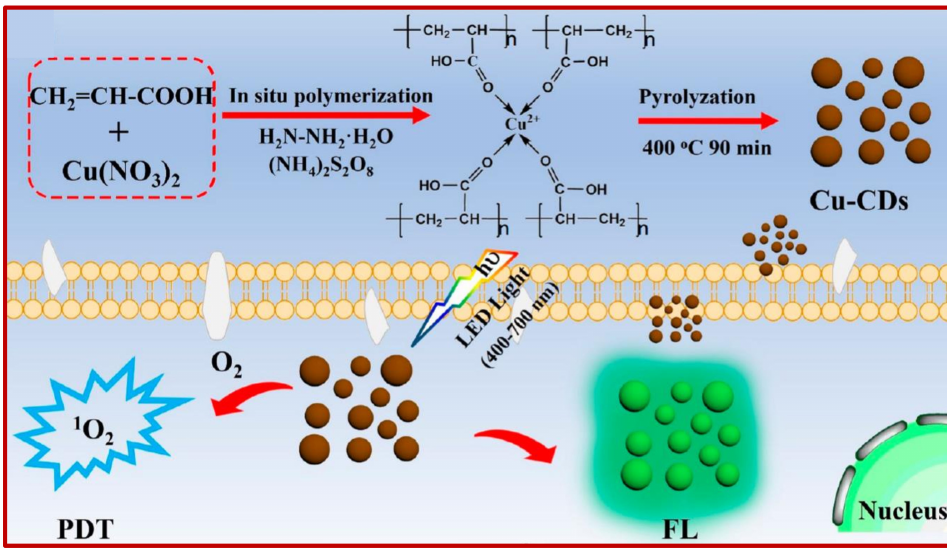
Figure 26. Graphical representation of the preparation of Cu-CDs, and their imaging-regulated appli- cation in photodynamic therapy. Reprinted from [324], with permission from American Chemical Society, 2019. FL: fluorescence; PDT: photodynamic